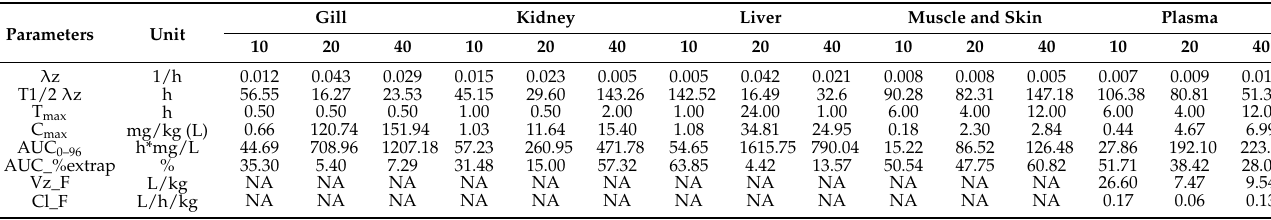
Table 2. The pharmacokinetic parameters of doxycycline in gill, kidney, liver, muscle and skin, and plasma of yellow catfish ( Pelteobagrus fulvidraco ) after a single oral dose of 10, 20, and 40 mg/kg, respectively.